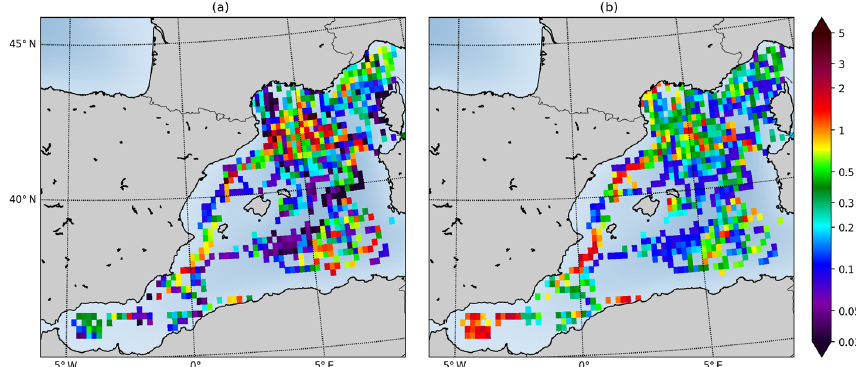
Figure 14. Sea surface Chl a from EMODnet dataset (a) and IBI36 (b) in mgChlm − 3 . IBI36 and EMODnet dataset are collocated in space and time between 2010 and 2016. Match-ups are averaged between 0 and 10m depth, gridded and averaged on a horizontal grid of 0 . 2 ◦ × 0 . 2 ◦ resolution.